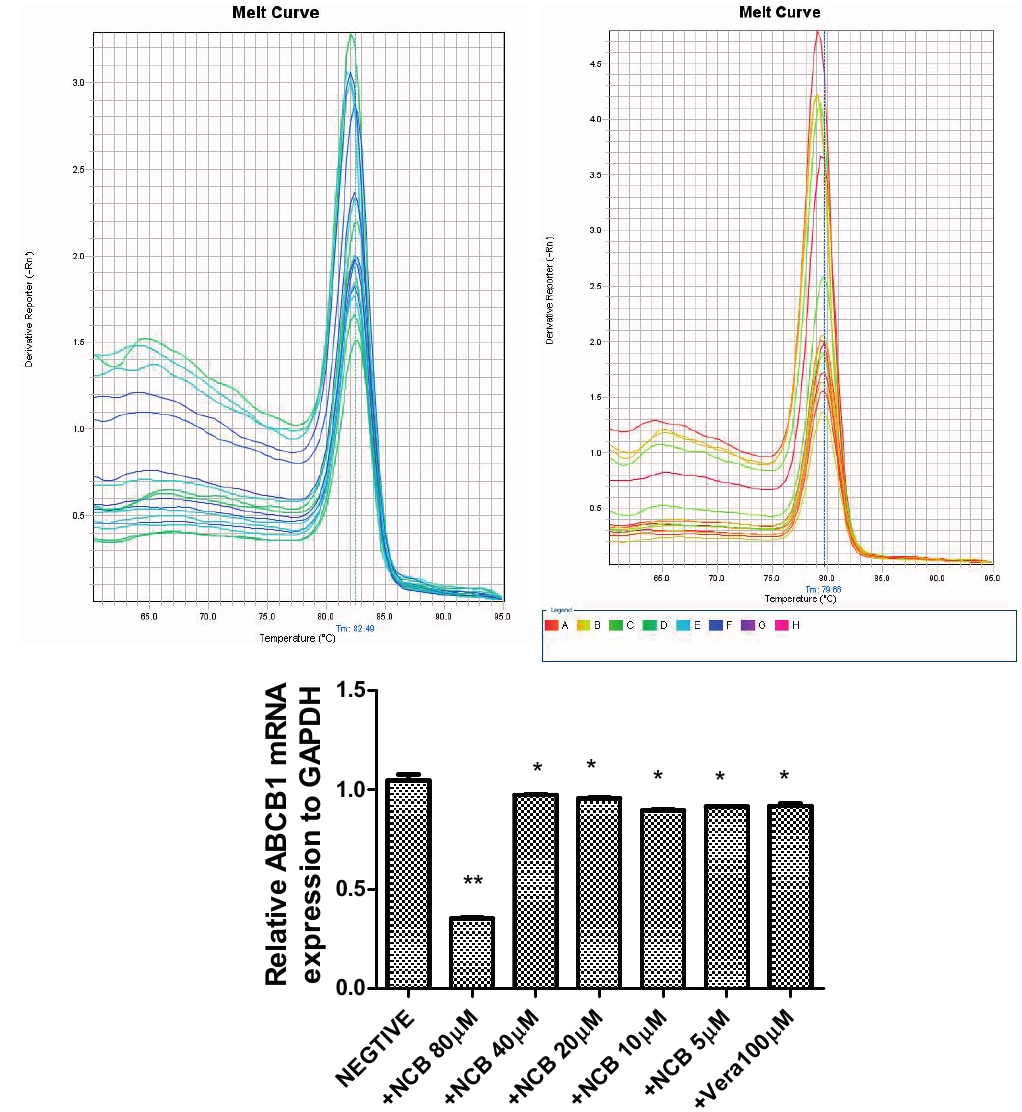
Figure 5. ABCB1 mRNA expression in the presence or absence of NCB and verapamil. ABCB1 mRNA was quantified by RT-PCR in MDCK-hMDR1 cells. Additionally, the relative gene expression levels were analyzed by the 2 −Δ Ct method. Negative, +NCB 80 μ M, +NCB 40 μ M, +NCB 20 μ M, +NCB 10 μ M, +NCB 5 μ M and +Vera 100 μ M refer to cells treated with HBSS, 80 μ M NCB, 40 μ M NCB, 20 μ M NCB, 10 μ M NCB, 5 μ M NCB and 100 μ M verapamil (figure above: Melting curve of GAPDH and ABCB1). * Statistically significant difference compared with controls ( p < 0.05), ** Statistically significant difference compared with controls ( p <